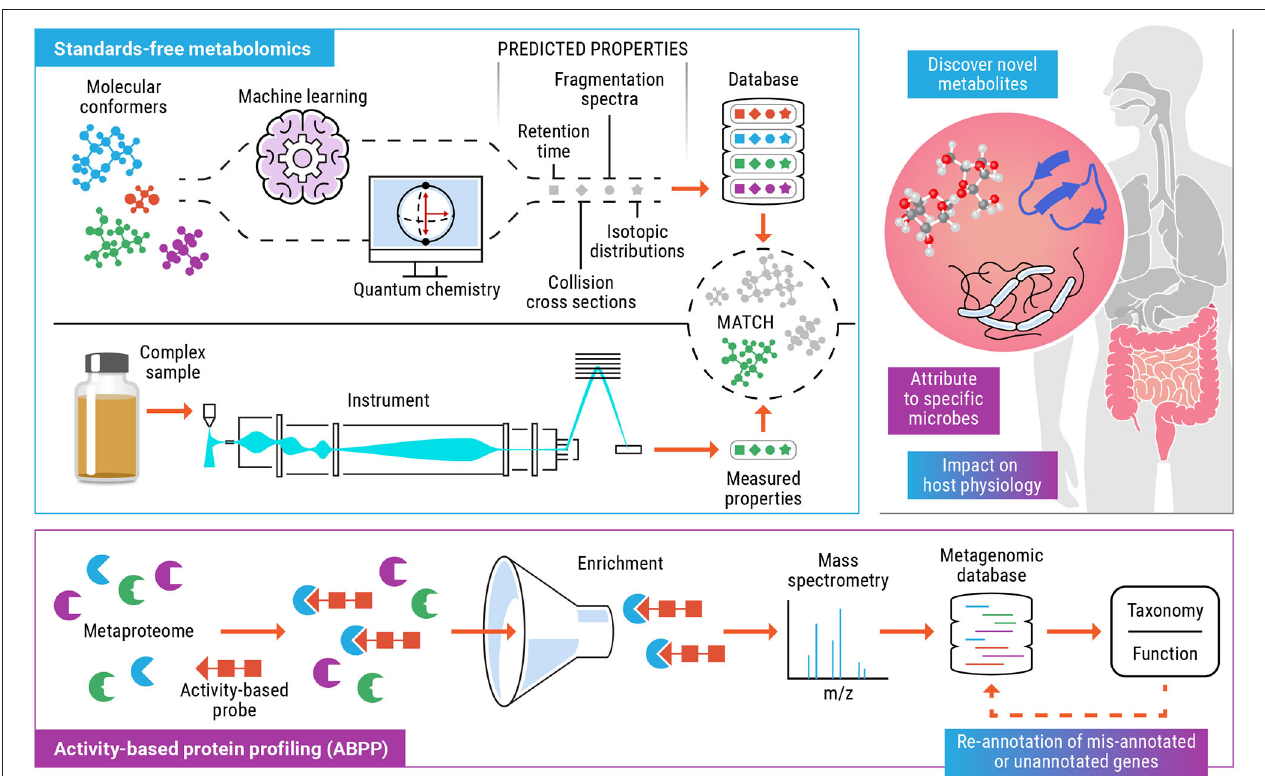
FIGURE 1 | Schematic for the combined use of standards-free metabolomics (blue) and activity-based protein profiling (purple) workflows to functionally characterize biomolecules, the microbial populations involved and their effect on the host. The colored text boxes (blue, purple, or blue + purple) indicate the data and understanding gained from either one or a combination of both